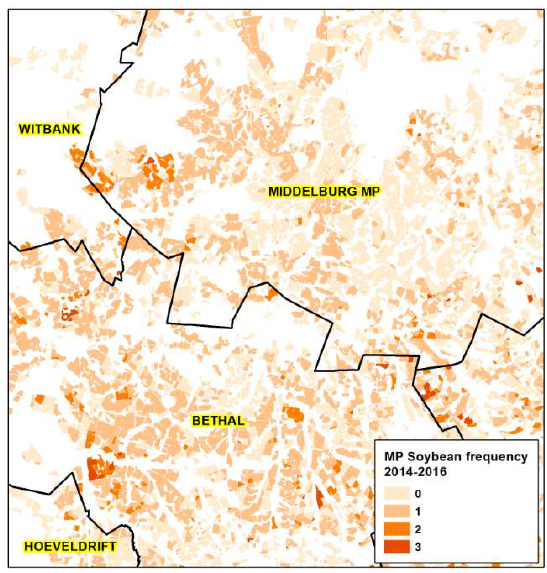
Figure 21. The frequency occurrence of soybeans per field between 2014 and 2016 in an area of Mpumalanga At the district level the area of rotation between two specific crops could now be calculated. The area of rotation is expressed as the amount of area of two specific crops that were rotated.